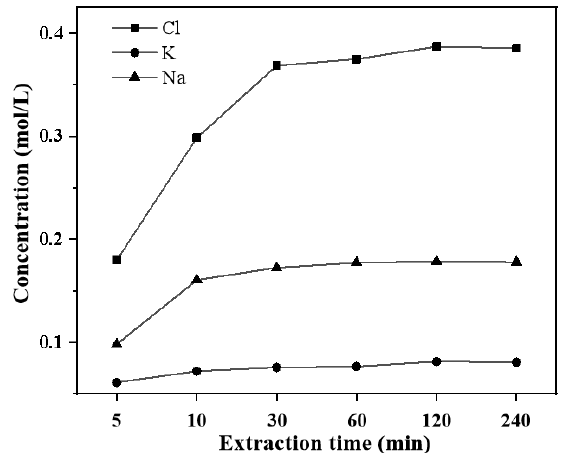
Figure 8. Composition changes in the extracting solution at different extraction times (mol/L).